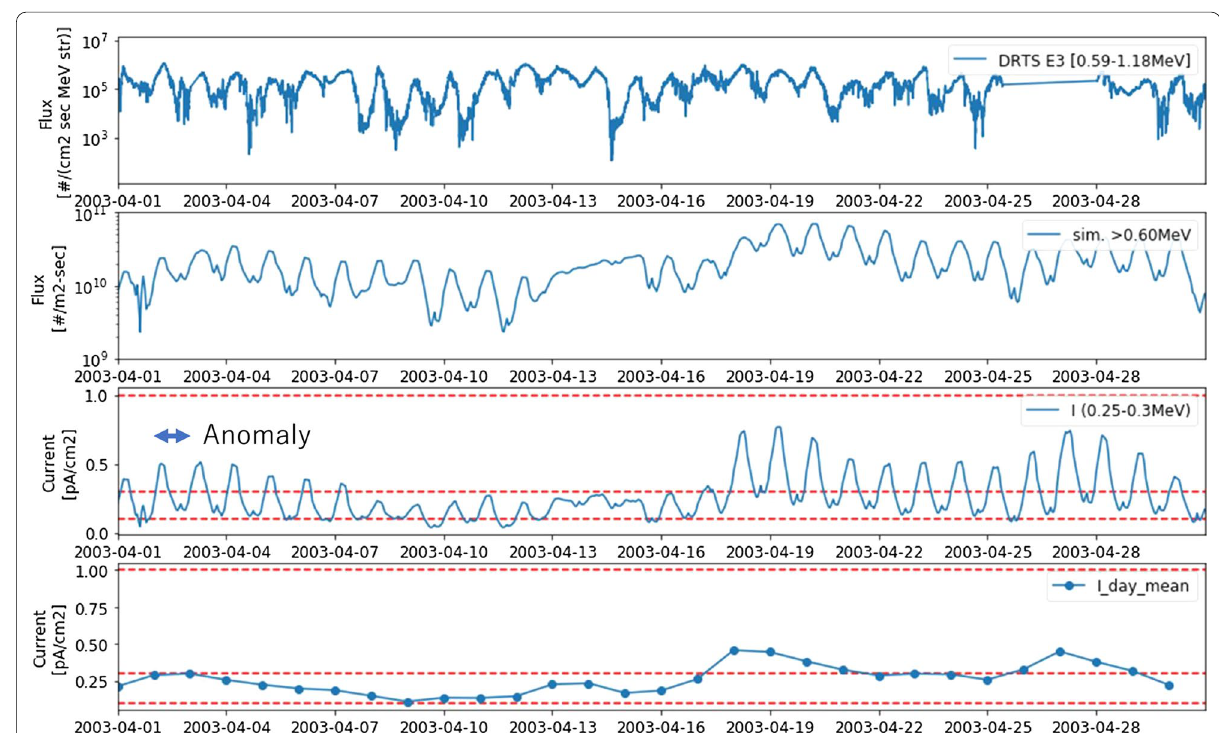
Fig. 11 Example of stacked plots for the risk assessment of internal charging/ESD. From top to bottom: differential electron flux observed by Ch.3 (0.59–1.18 meV) of SDOM/Kodama, and differential electron flux estimated using the radiation belt model, current accumulated inside the target material ( d 2 ), and daily mean of current accumulated inside the target material ( d 2 ). The three dotted lines show the current levels of 0.1, 0.3, and 1.0 pA/cm 2 in accordance with the ESD risk. The arrow shows the anomaly event of the ESA that occurred on April 2,